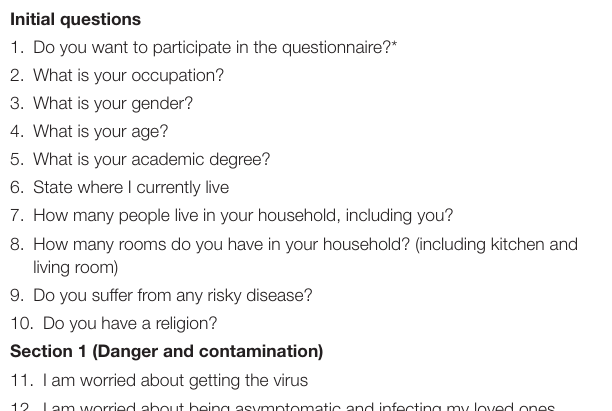
TABLE 1 | COVID-19 Vaccine Acceptance and Hesitancy Questionnaire (COV-AHQ). Initial